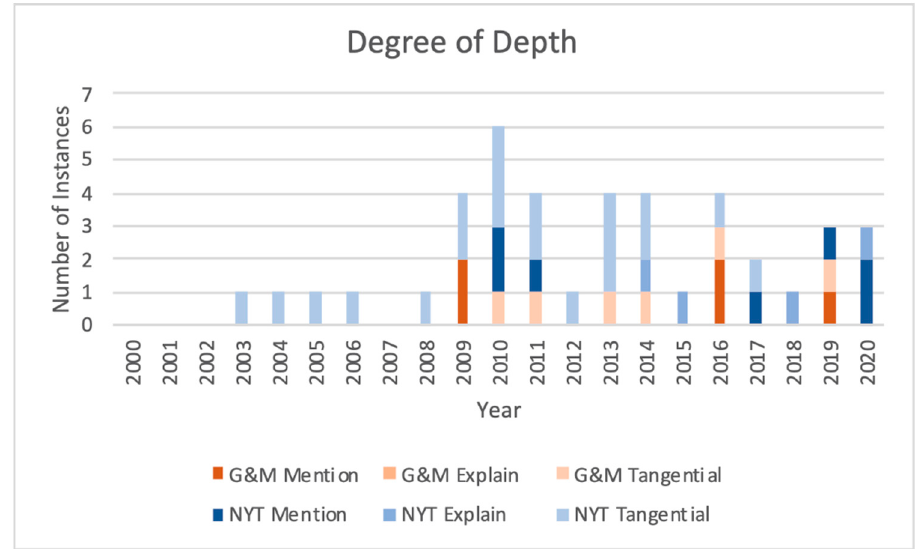
Figure 1. Depth of coverage of eDNA in the Globe and Mail and the New York Times , 2000–2020.